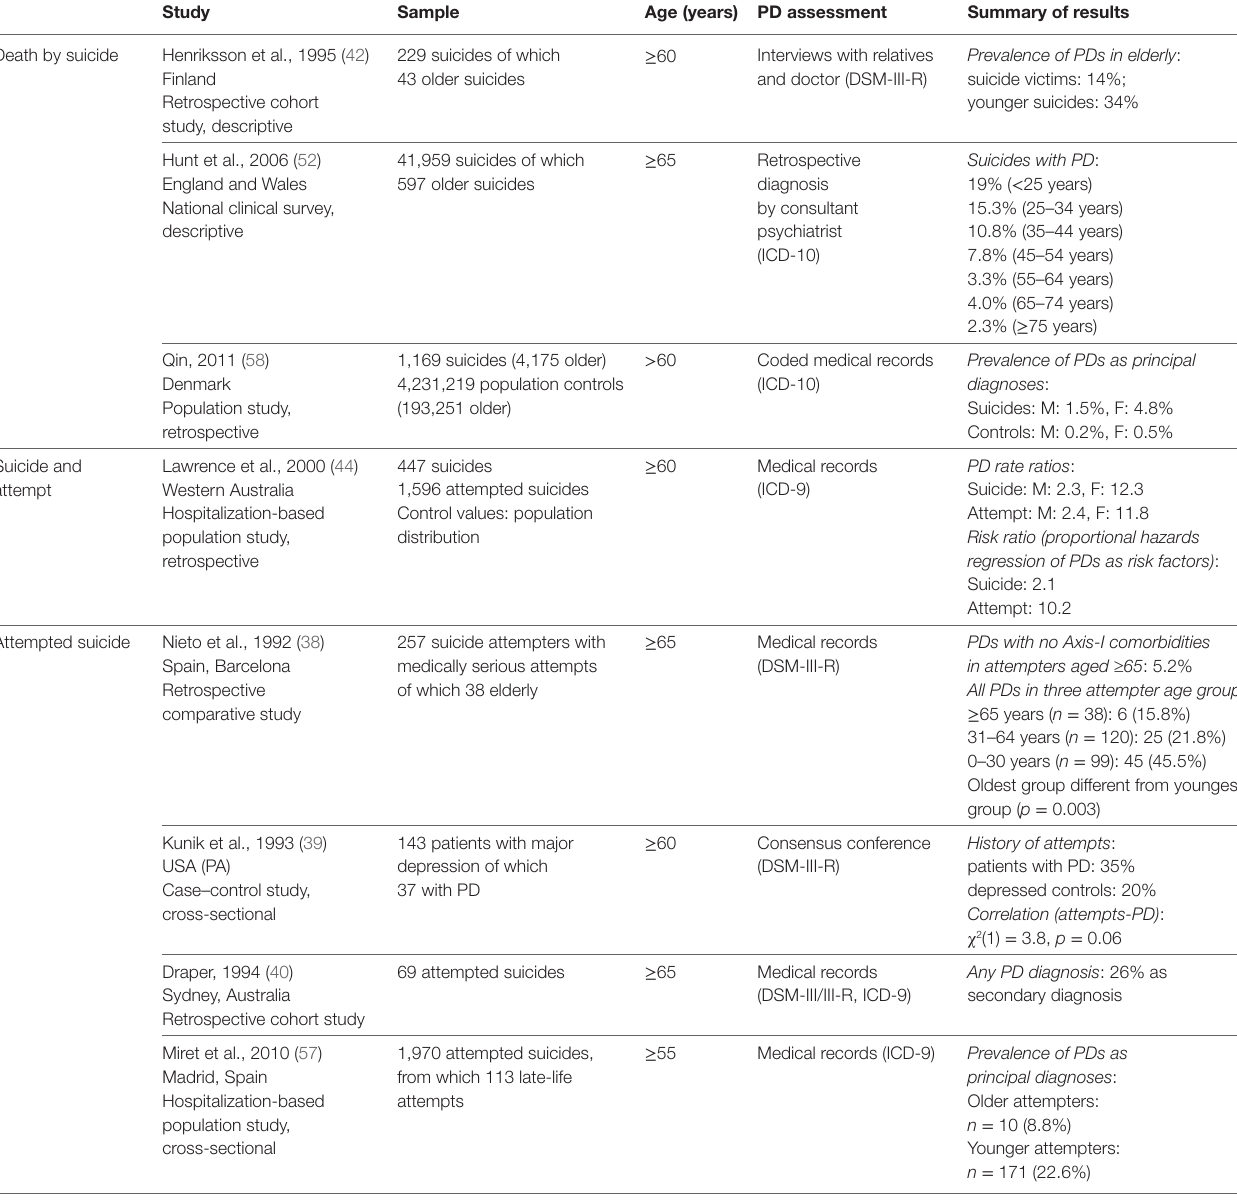
taBLe 1 | Studies with categorical measures reporting globally on personality disorders.